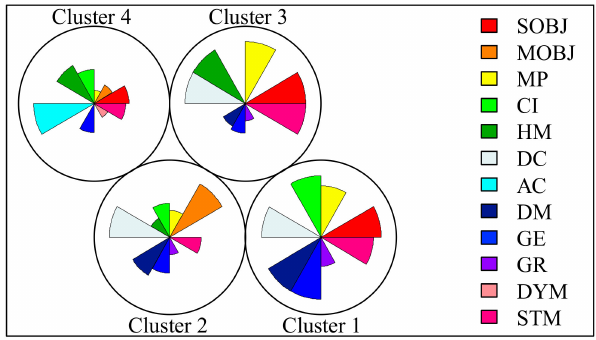
Figure 9. Main attributes of each